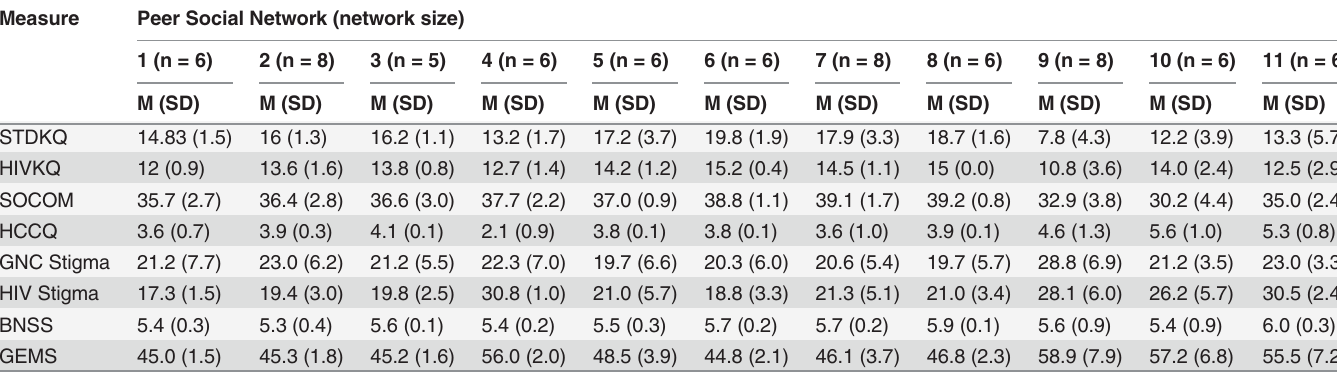
Table 5. Means and standard deviations on psychosocial variables for peer networks 1 – 11. Measure Peer Social Network (network size)